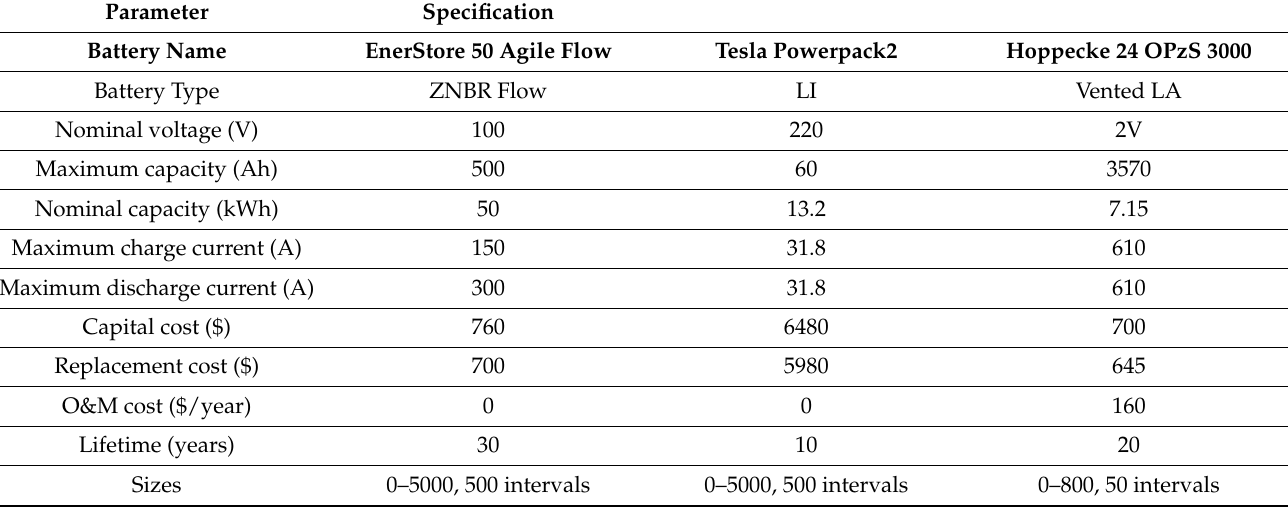
Table 2. Specification data of